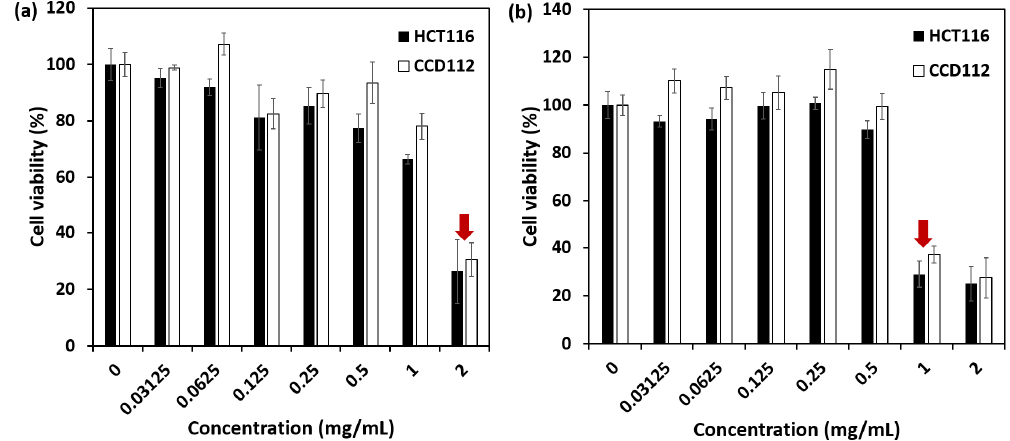
Figure 10. Cell viability of HCT116 and CCD112 cell lines after treatment of ( a ) MMT / CR / Fe 3 O 4 -NCs and ( b ) MMT / CR / Fe 3 O 4 -PCA at various concentrations. Red arrows show approximately 70% of growth inhibition of the tested cells.